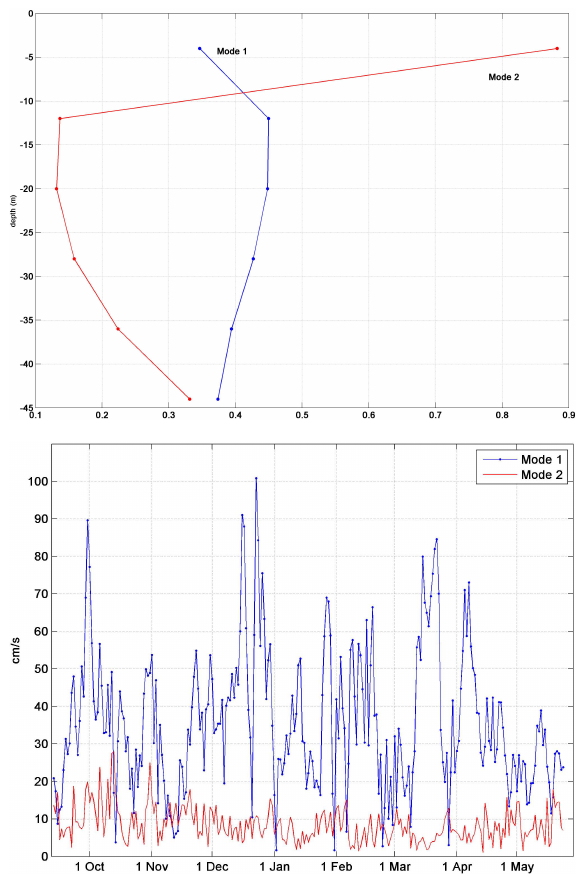
Fig. 10. Complex EOF decomposition of daily mean time series of ADCP currents: magnitude of first two modes profiles (a) and temporal series of coefficients (b) .